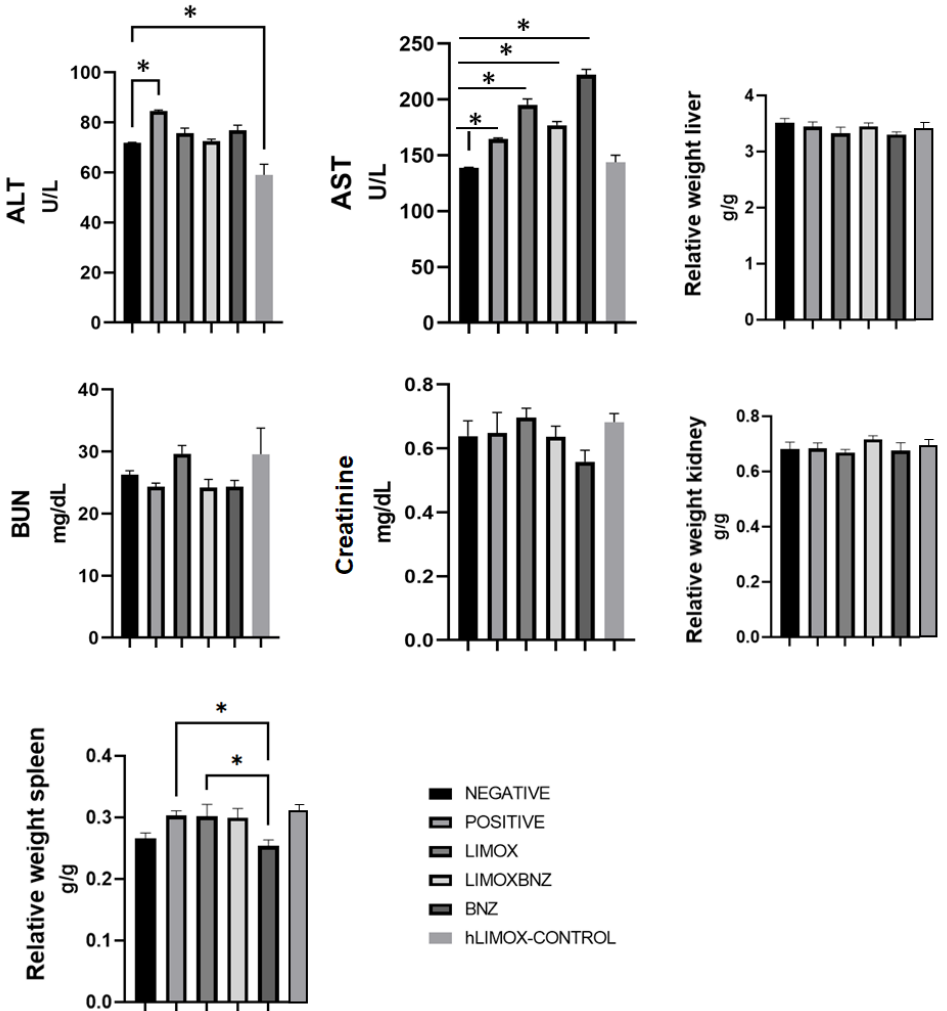
Figure 5. Toxicity of the tested therapies in the liver and spleen. ALT: Alanine aminotransferase; AST: Aspartate aminotransferase; BUN: Blood urea nitrogen. * p ≤ 0.005 compared to the Benznidazole group. Negative control: untreated, uninfected animals; hLIMOX-Control: not infected animals treated with higher doses of an essential oil fraction of Lippia alba carvone chemotype enriched in limonene (170 mg/kg/day) and with added caryophyllene oxide (Sigma-Aldrich) (70 mg/kg/day); Positive control: untreated, infected animals; LIMOX: infected animals treated with a mixture of an essential oil fraction of Lippia alba carvone chemotype (enriched in limonene) (68.9 mg/kg/day) and with added caryophyllene oxide (Sigma-Aldrich) (70 mg/kg/day); LIMOXBNZ: infected animals treated with LIMOX plus benznidazole (7.9 mg/kg/day); BNZ: infected animals treated with benznidazole (100 mg/kg/day). * p ≤ 0.05. Data are representative of six independent experiments and values are expressed in mean ± SEM.